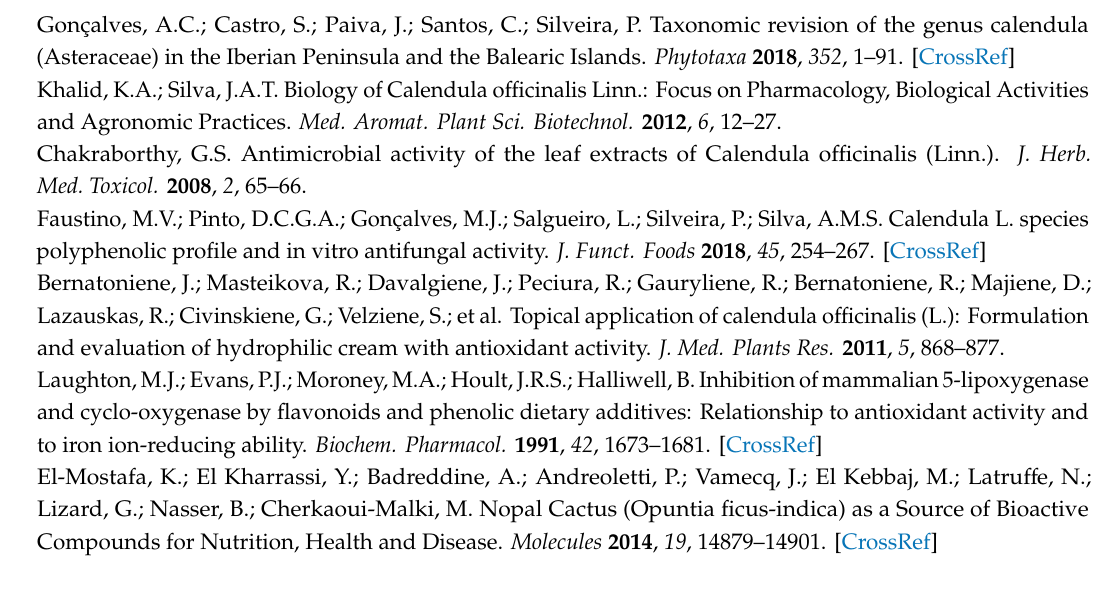
Table S1: Statistical analysis performed on the yield (g / 100g) determined on the matrix of dried leaves of four Calendula taxa ( CM: C. maritima; CF: C. fulgida; CI: C. hybrid (maritima × fulgida); CA: C. arvensis), with di ff erent solvents; Table S2: Statistical analysis performed on total phenolic content (mg GAE / g) in extracts obtained from dried leaves of four Calendula taxa ( CM: C. maritima; CF: C. fulgida; CI: C. hybrid (maritima × fulgida); CA: C. arvensis ), with di ff erent solvents, Table S3: Statistical analysis performed on DPPH radical scavenging activity (IC 50, mg / ml) determined in extracts obtained from dried leaves of di ff erent Calendula species ( CM: C. maritima; CF: C. fulgida; CI: C. hybrid (maritima fulgida); CA: C. arvensis ), with di ff erent solvents, Table S4: Statistical analysis performed on reducing power (EC50, mg / ml) determined in extracts obtained from dried leaves of di ff erent Calendula species ( CM: C. maritima; CF: C. fulgida; CI: C. hybrid (maritima × fulgida); CA: C. arvensis ), with di ff erent